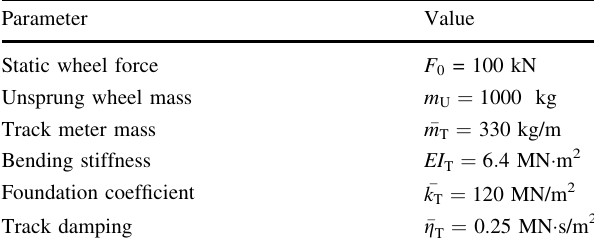
Table 1 Parameters of the dynamic